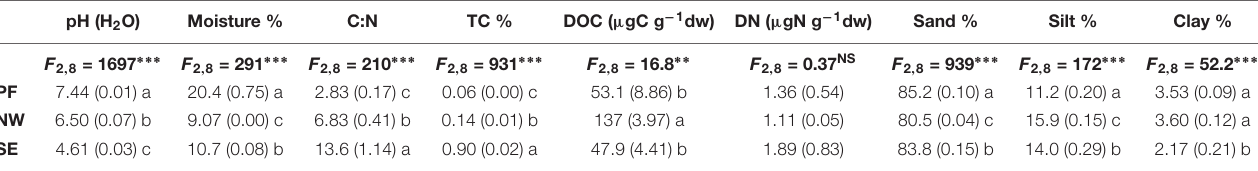
Statistics: F-ratio test (F) determined by a GLM model with a Gamma distribution to assess differences between the soils. Asterisks indicate significant differences with ∗∗∗ p < 0.001, ∗∗ p < 0.01. Soil properties: TC, total organic carbon; TN, total nitrogen; DOC, dissolved organic carbon; DN, dissolved nitrogen. Soil origins: PF, permafrost; NW, active layer on north-western slope; SE, active layer on south-eastern slope. Values in brackets indicate mean ± standard error (within each soil, n = 3). Different lowercase letters indicate significant differences (p < 0.05) between soils (multiple comparisons using Tukey post hoc test).